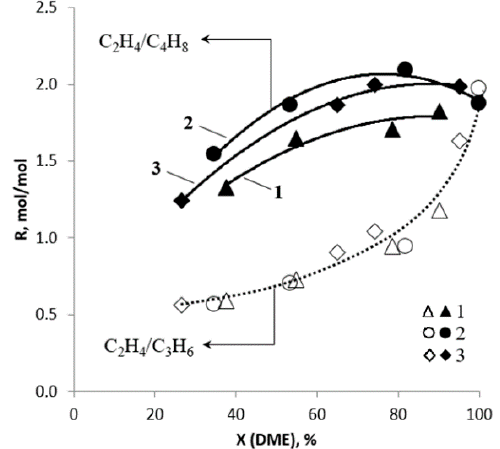
Figure 7. Yield of methanol (Y, mol %) as a function of specific contact time ( τ , g(cat) / g(C)*h) for Mg-HZSM-5 / Al 2 O 3 . Experimental values are in solid line, theoretic values are in dashed line.